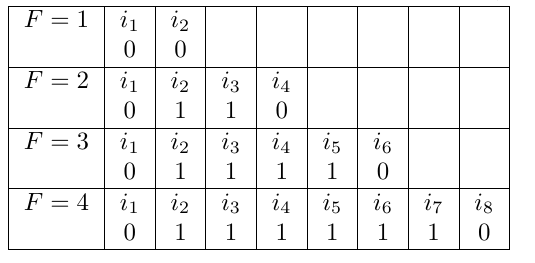
Table 3: Number of permutations of harmonic ω 0 ( N 2 ω